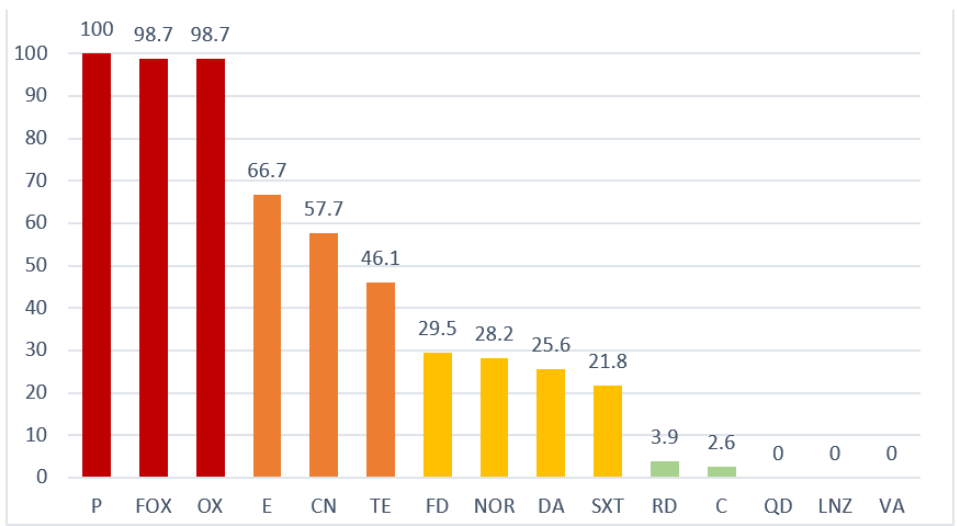
Figure 1. Percentage of Staphylococci resistant to different antimicrobials isolated from the staff